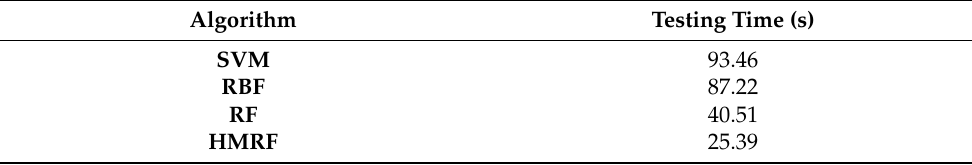
Table 3. Comparison of average testing time of different classification